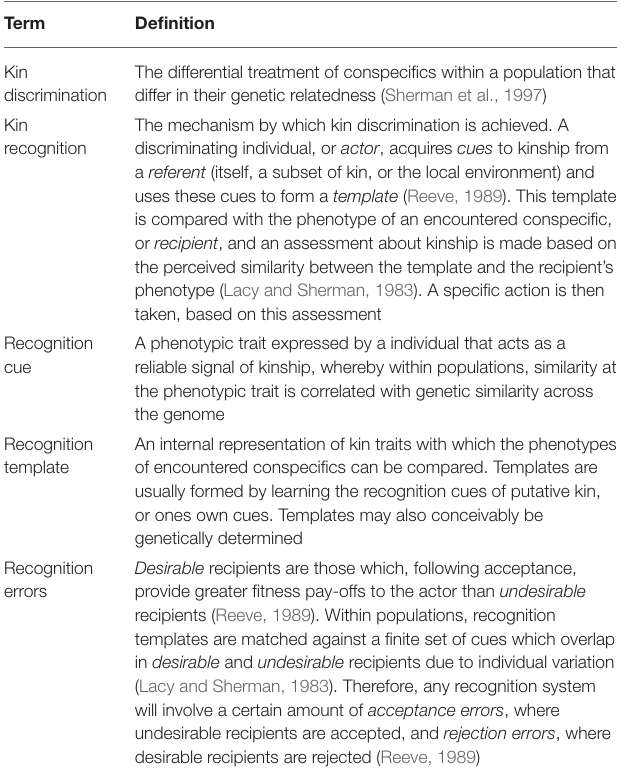
TABLE 1 | Key terms in kin recognition